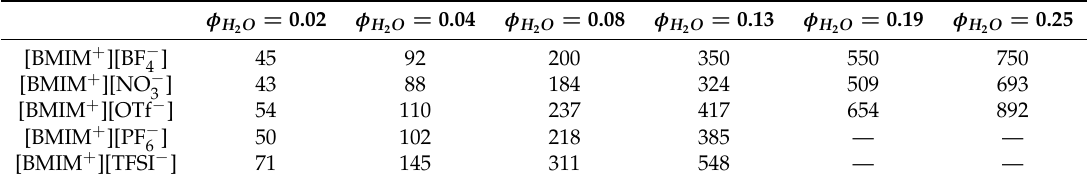
Table 1. Number of water molecules in ionic liquid (IL)/water systems for specified water volume fraction, φ H . All systems contain 220 ion 2 O